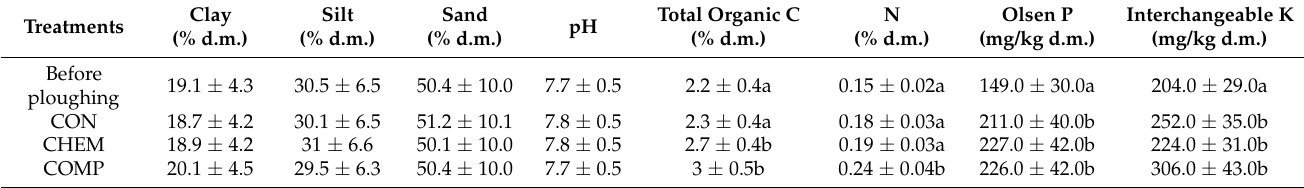
Table 1. Main physical and chemical characteristics and standard deviation of the soil tested. In each column, values with different letters indicate mean values significantly different according to the Tukey’s post hoc test performed on results of ANOVA with p -value < 0.05 CON = Control; CHEM = chemical fertilizer; COMP = Compost.